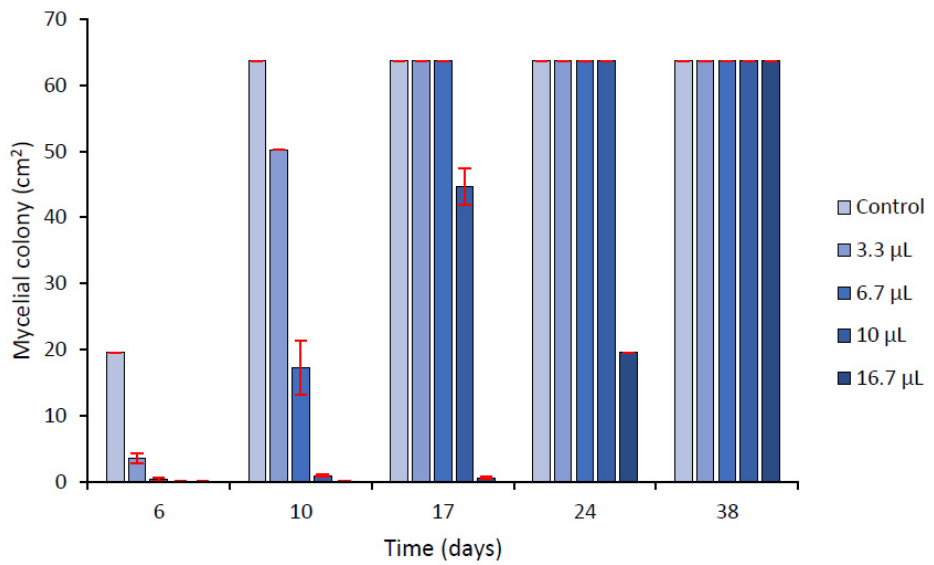
Figure 2. Mycelial growth of F. avenaceum in presence of different quantities of volatile compounds of A. pusilla EO (AP1). The volumes in µ L are the quantity of EO per L of air. Means of 3 replicates. of A. pusilla EO (AP1). The volumes in µL are the quantity of EO per L of air. Means of 3 replicates. Errors bars are ± standard deviations. Errors bars are ± standard